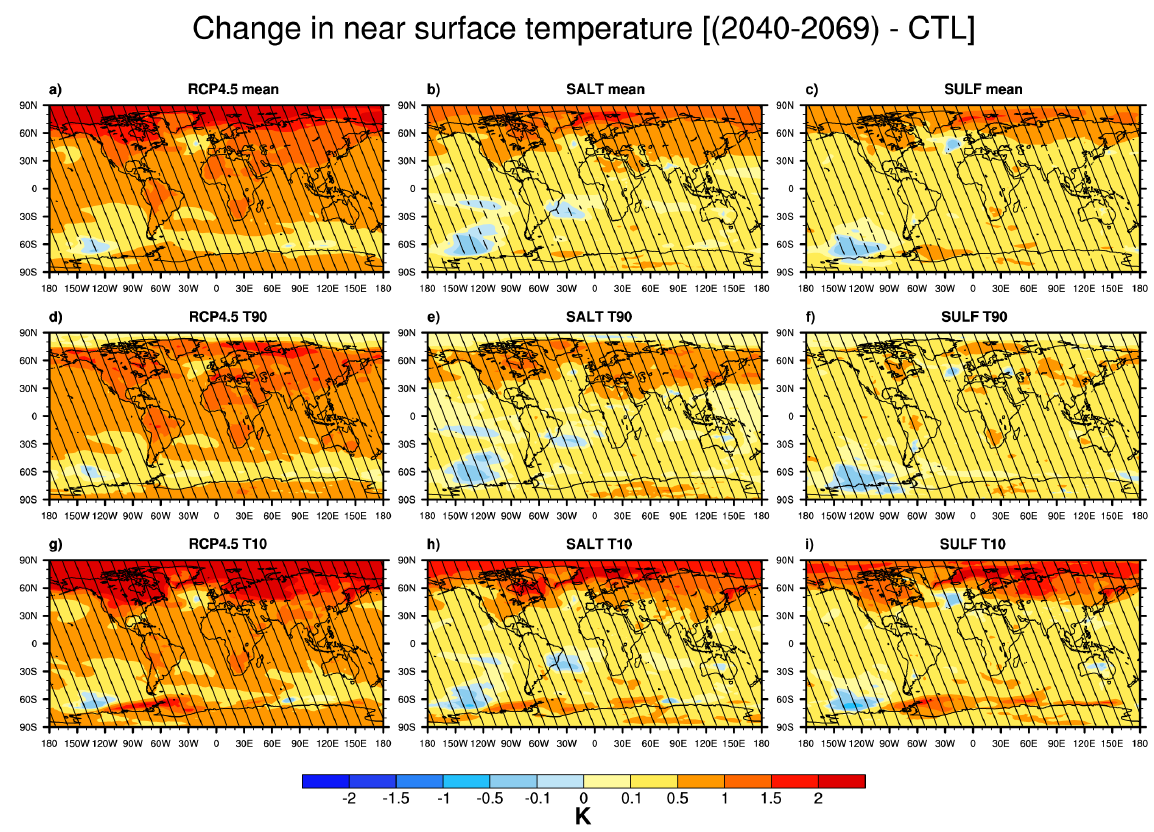
Figure 1. Multi-model mean change in near-surface temperature (K) for RCP4.5 (left column), SALT (middle) and SULF (right column) for 2040–2069 minus the RCP4.5 control period (CTL; 2006–2035). Panels (a) to (c) denote changes in mean values, (d) to (f) same as (a) to (c) but for the 90th percentile and (g) to (i) same as (a) to (c) but for the 10th percentile of the temporal distribution at each model grid point. Hatches denote regions where the changes are 95% statistically